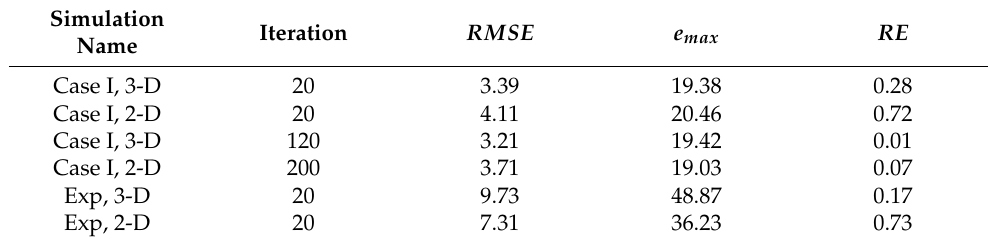
Figure 6. 3-D reconstructions, same as Figure 5 but with vectorial Green’s function in (13), for “Case I” of Figure 2 at 1.0 GHz. ( a – c ) Relative permittivity (cid:60) ( ε r ) for the y-z, x-z, and x-y slices, respectively. Table 3. Reconstruction errors for the cases considered in Section